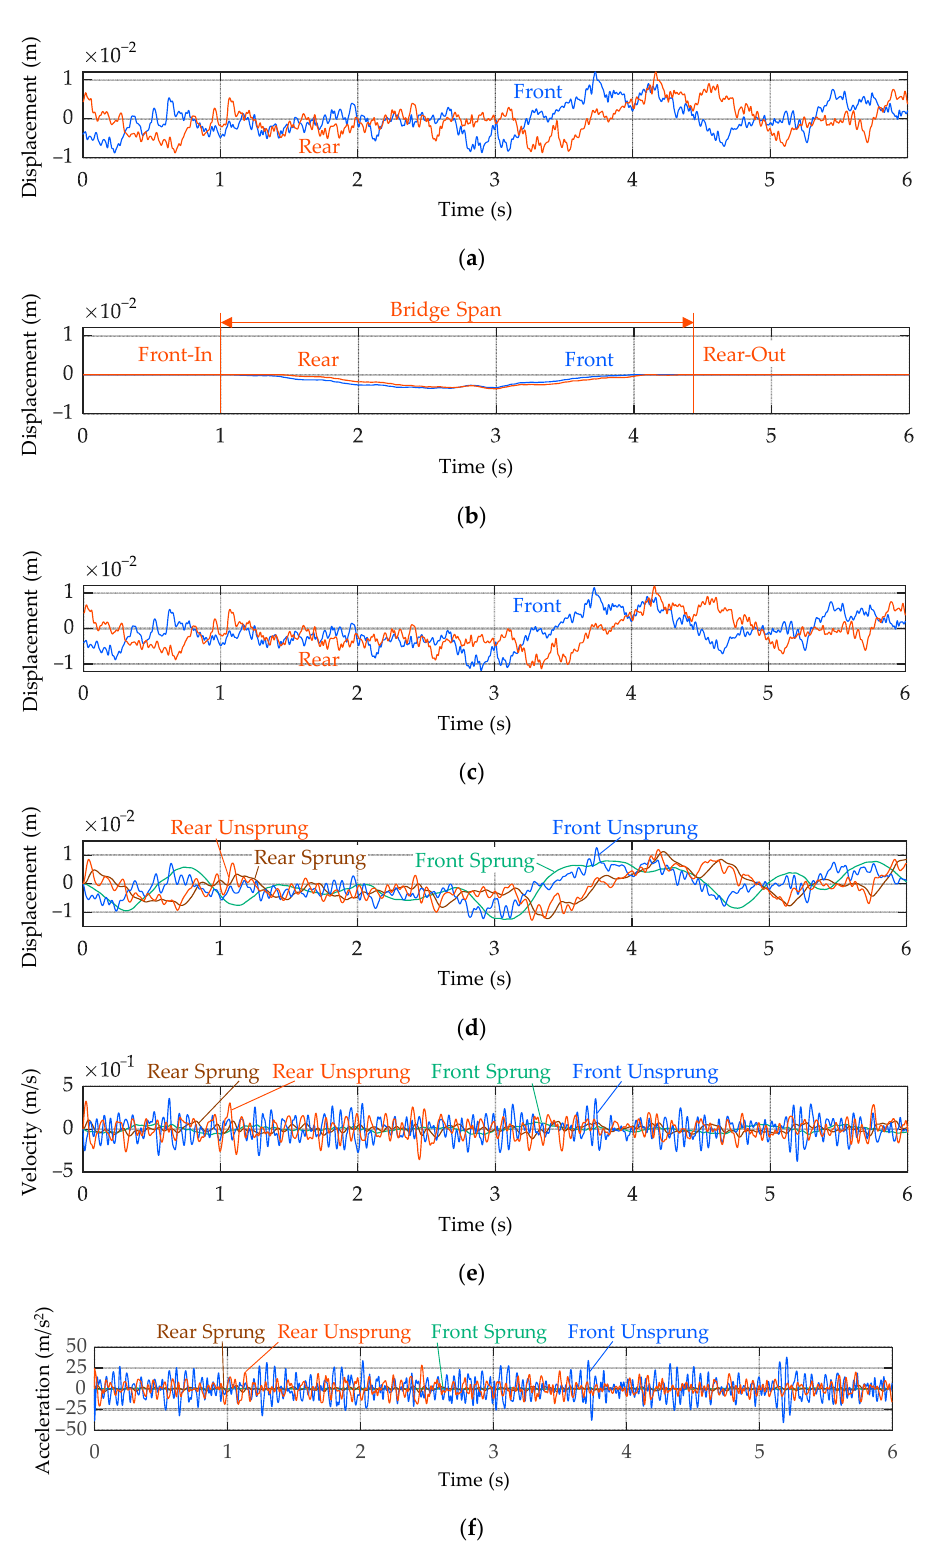
Figure 5. The vehicle vibration accelerations, velocities and displacements, and profiles: ( a ) road profiles r ( t ) = { r i ( t ) } = { R ( x i ( t )) } ; ( b ) bridge profiles (cid:101) y ( t ) = { y ( x i ( t ) , t ) } = { N ( x i ( t )) · y ( t ) } ; ( c ) input profiles u ( t ) ; ( d ) vehicle vibration displacement z ( t ) ; ( e ) vehicle vibration velocity: .. z ( t ) ( f ) vehicle vibration acceleration: